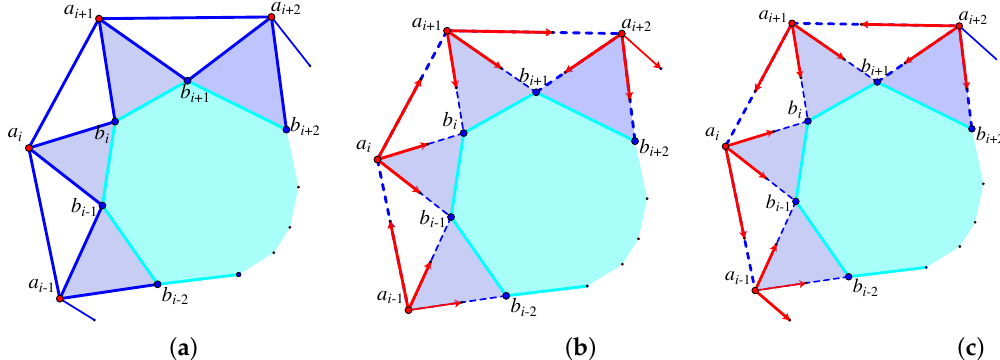
Figure 30. The 3-isostatic graph in ( a ) has a generically rigid turquoise n -gon. With that central n -gon tied down, the remaining edges have two 3-directed orientations ( b , c ) which each give a term summing to the larger pure